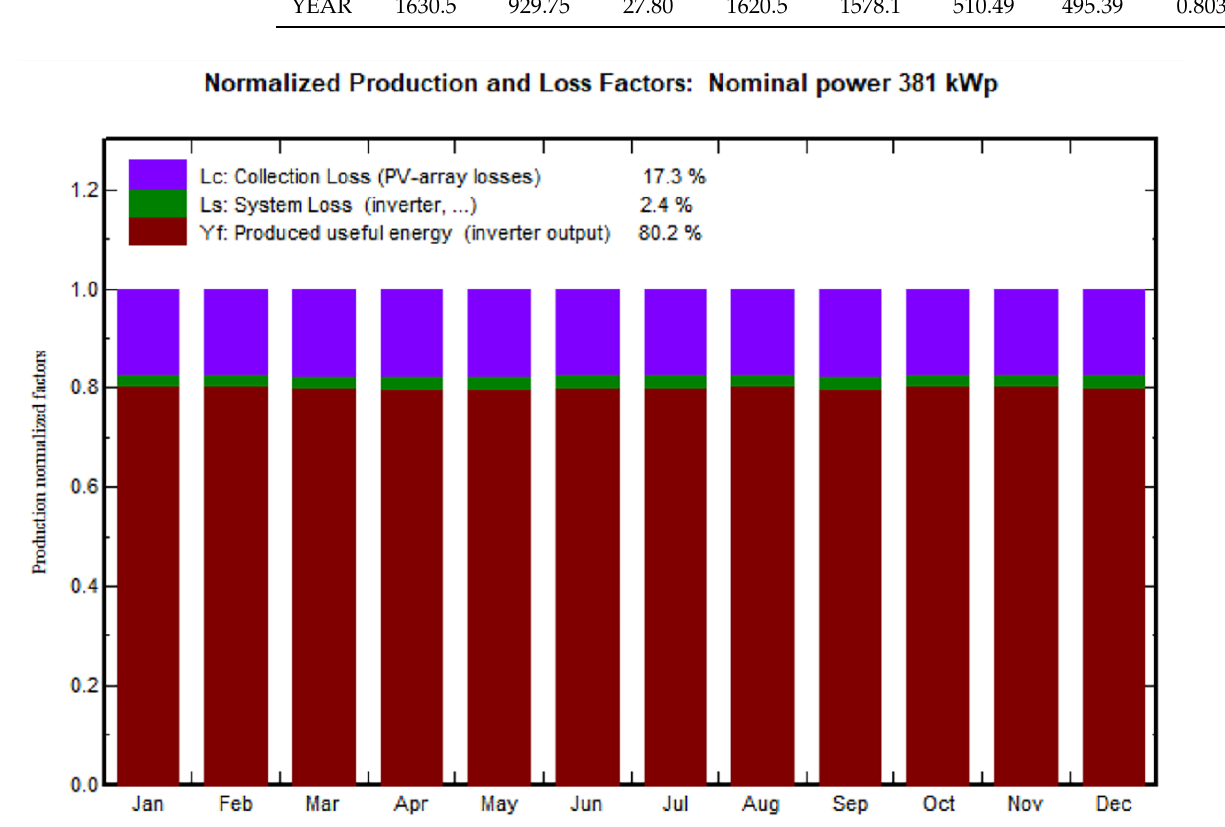
Figure 2. Normalized production (per installed kWp). The yield factor was defined to be a factor consolidating all the system losses that occurred across this power plant. The major losses that occurred during the operation of the solar PV power plant were temperature loss, module mismatch loss, and DC to AC conversion losses. Figure 3 presents the loss diagram over the whole year. The diagram represents the energy flows in the system and the losses from every parts. Figure 3 shows that the largest losses came from temperature with 7.77%, while the inverter loss was 1.47%, which is expected from the manufacturing datils of the